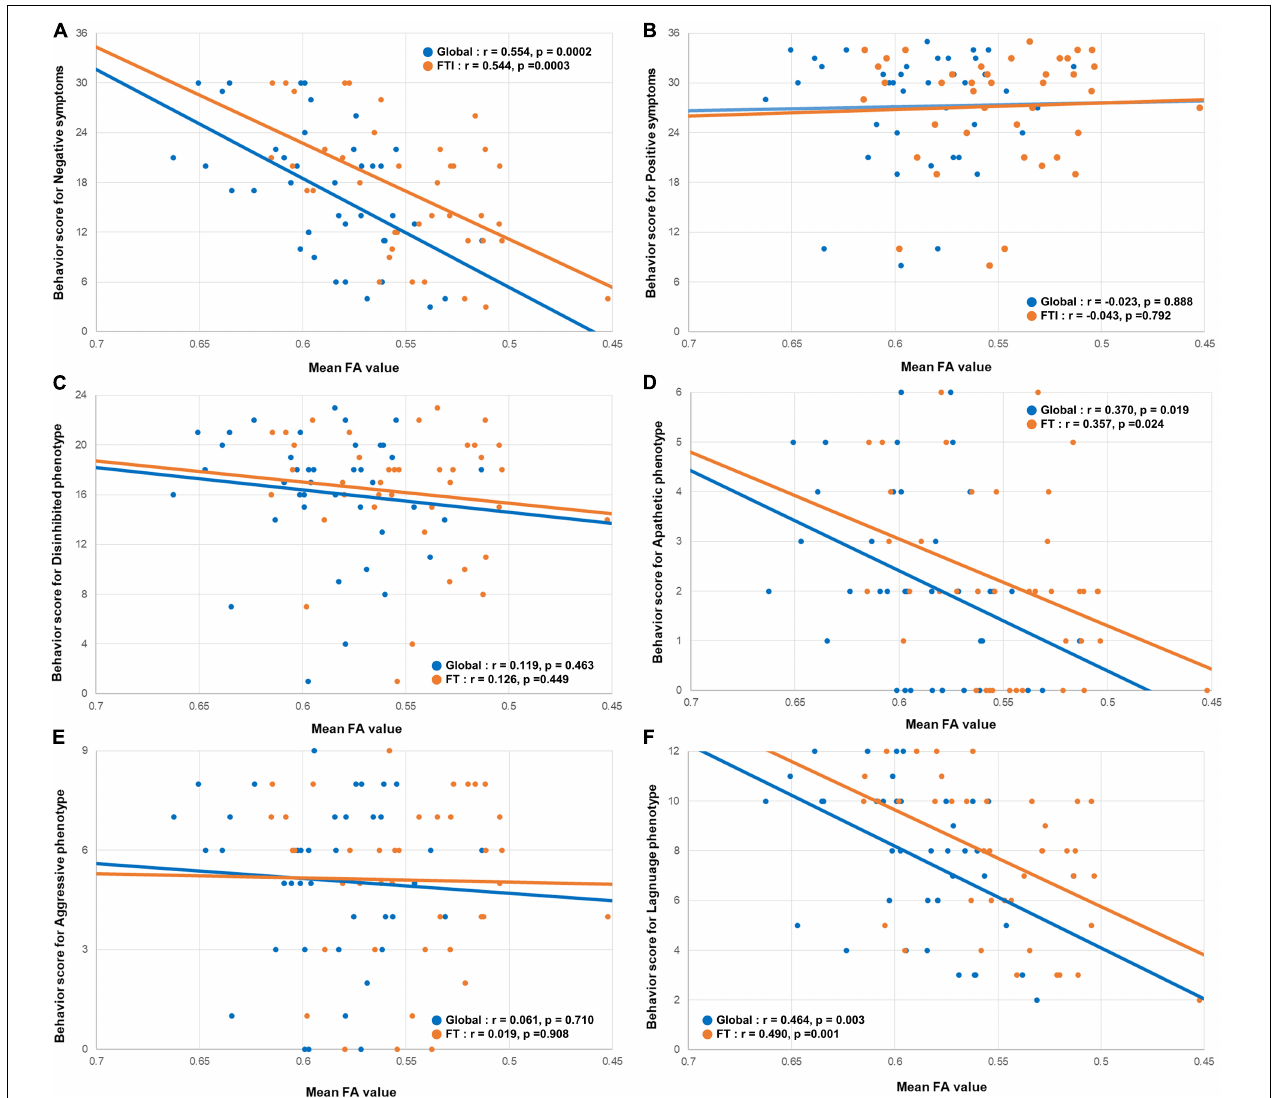
FIGURE 3 | Correlation between the mean FA value and the behavioral scores. Scatterplots showing the relationship between the behavioral scores for negative symptoms and the behavioral variant frontotemporal dementia neuropathology imaging biomarkers. (A) The behavioral scores for negative symptoms were positively correlated with the global mean FA, and mean FA value of the frontotemporal WM. (B) The behavioral scores for positive symptoms were not correlated with the global mean FA, and mean FA value of the frontotemporal WM. In phenotype aspects. (D,F) The behavioral scores for apathetic and language phenotypes were positively correlated with the global mean FA, and mean FA value of the frontotemporal WM. (C,E) The behavioral scores for disinhibited and aggressive phenotype were not correlated with the global mean FA, and mean FA value of the frontotemporal WM. FA, fraction anisotropy; WM, white